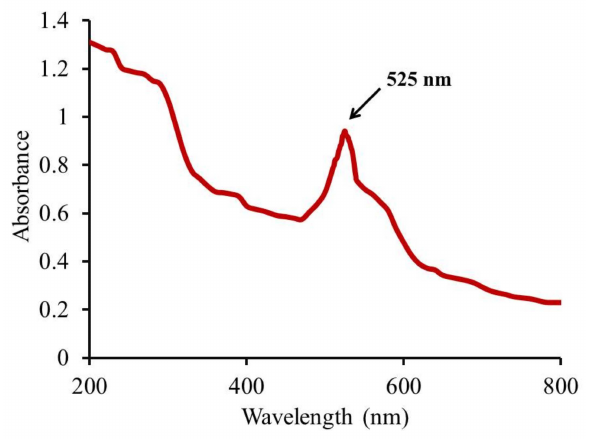
Figure 1. UV scanning of fabricated gold NP.